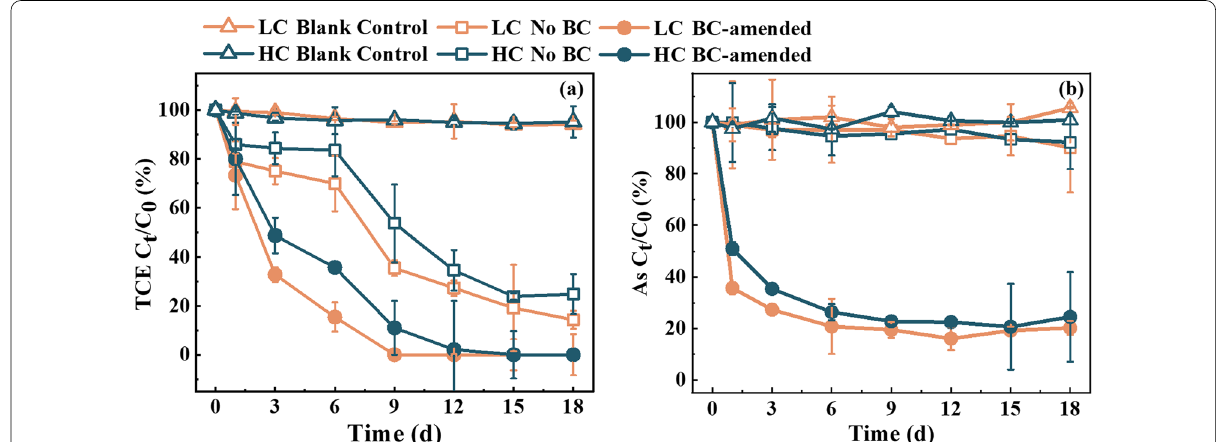
Fig. 1 Removal dynamics of TCE ( a ) and total As ( b ) from the contaminated groundwater by microbes with the assistance of biochar. LC: Low concentration of contaminants, 10 mg L − 1 TCE with 1 mg L − 1 As(V); HC: High concentration of contaminants, 30 mg L − 1 TCE with 4 mg L − 1